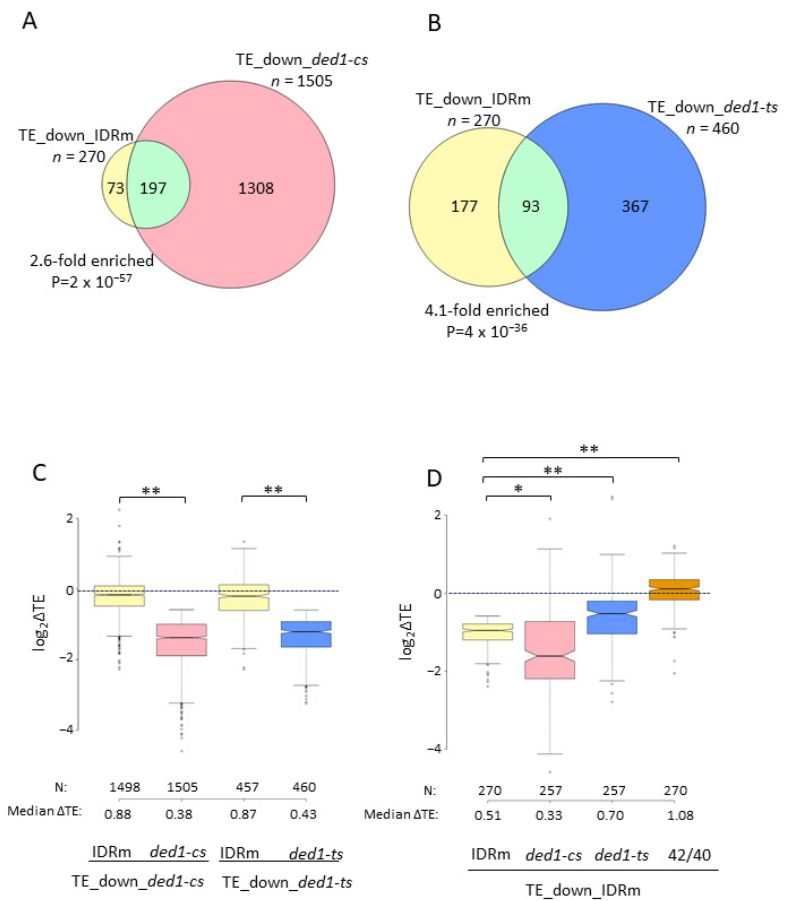
Figure 2. A significant fraction of Ded1-hyperdependent mRNAs translationally down-regulated by the ded1-ts or ded1-cs mutations is translationally down-regulated by the DED1-IDRm mutation at 42 ◦ C. ( A , B ) Overlap between 270 mRNAs exhibiting ≥ 1.5-fold reductions in TE in DED1-IDRm versus WT cells at 42 ◦ C (TE__down_IDRm) and either the TE_down_ ded1-cs group from Figure 1A ( A ) or the TE_down_ ded1-ts mRNAs from Figure 1C ( B ). ( C ) Notched box plots showing log 2 fold- changes in TE in response to the ded1-IDRm mutation at 42 ◦ C ( IDRm /WT), ded1-cs, or ded1-ts mutations for the 1505 TE_down_ ded1-cs mRNAs (cols. 1–2) or 460 TE_down_ ded1-ts mRNAs (cols. 3–4). ( D ) Log 2 fold-changes in TE in response to the ded1-IDRm mutation at 42 ◦ C, ded1-cs, ded1-ts, or heat-shock at 42 ◦ C vs. 40 ◦ C for the 270 TE_down_IDRm mRNAs. One outlier mRNA was omitted from the plot to expand the y -axis scale. p -values computed from Mann–Whitney U -test are given (* p < 10 − 10 ; ** p < 10 − 15 ).